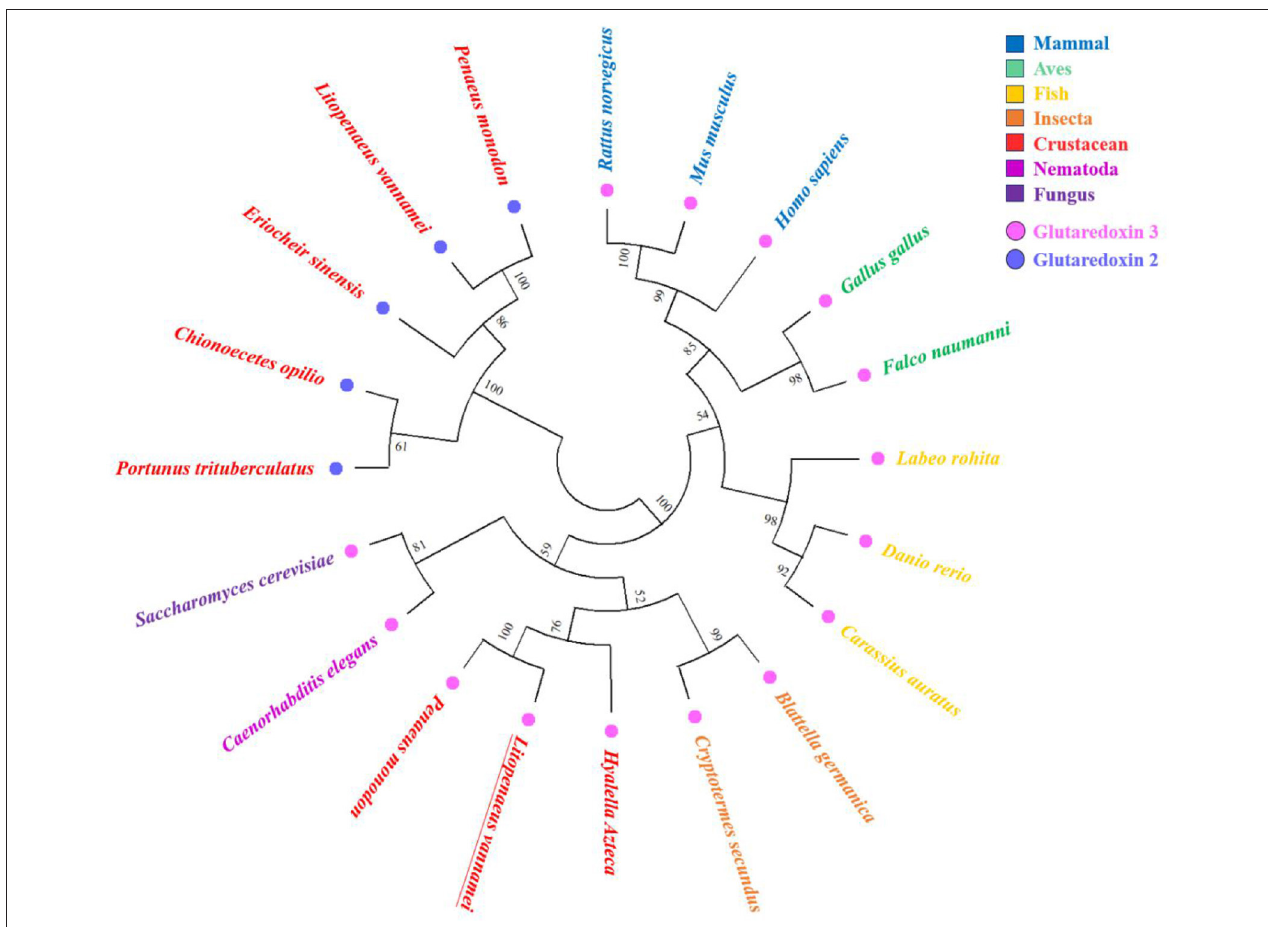
FIGURE 3 | Phylogenetic tree using 15 sequences of Grx 3 and five sequences of Grx 2 from various species. Amino acids sequences are aligned using the ClustalX software, and the tree is constructed with the neighbor-joining (NJ) method in Molecular Evolutionary Genetics Analysis (MEGA) 4. The numbers at the forks indicate the bootstrap values. The corresponding species in different colors are presented on the right side of the figure. The pink dots indicate Grx 3, and the blue dots indicate Grx 2. LvGrx 3 is underlined in the